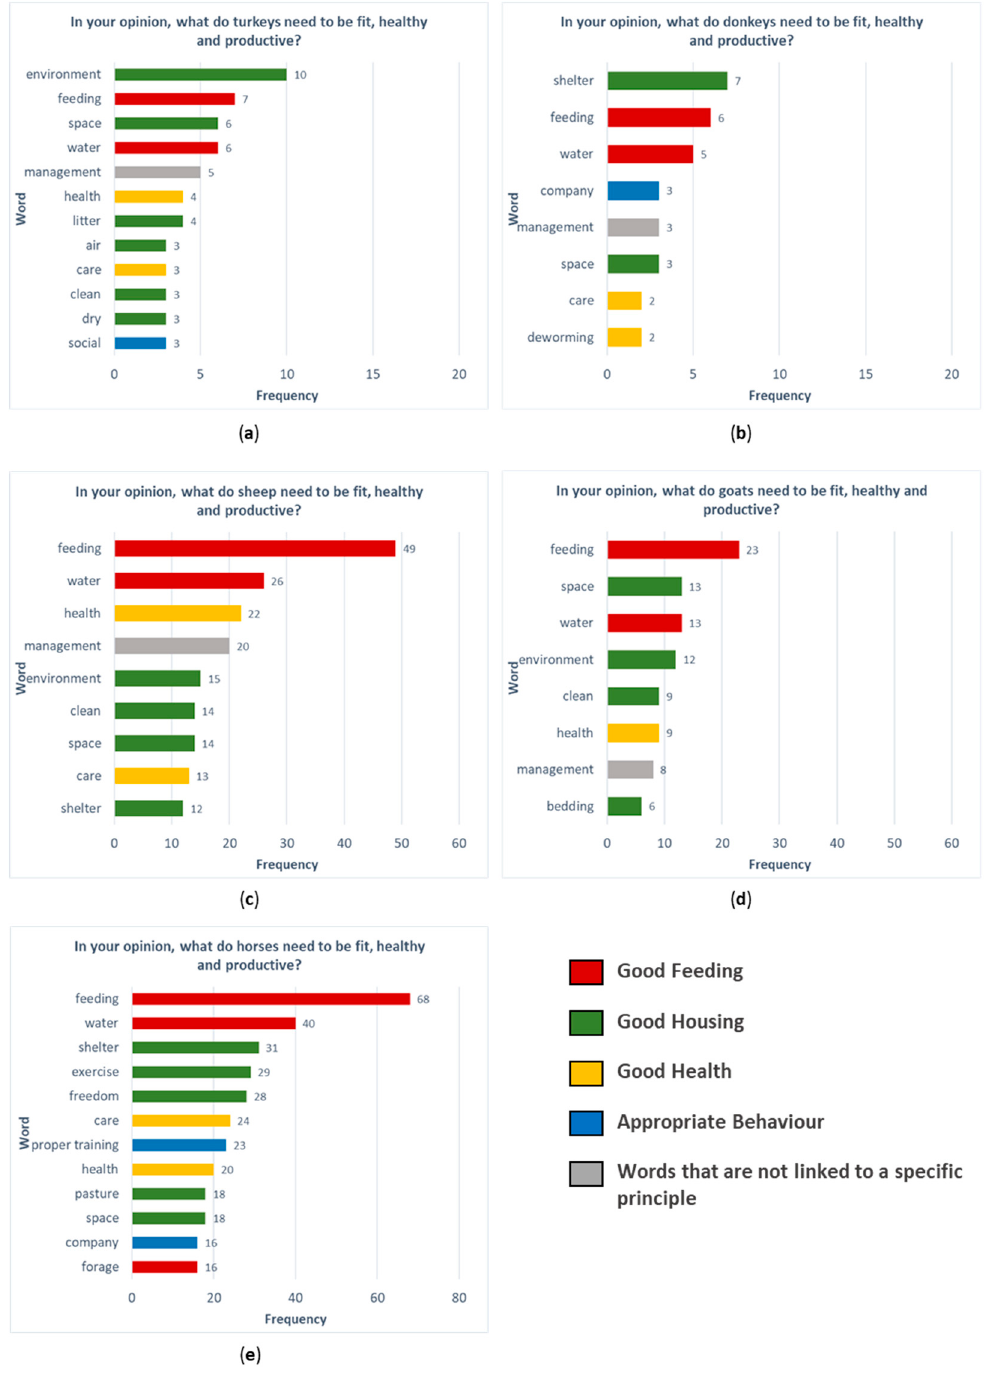
Figure 1. The graphs report the frequency of words used to answer the question “In your opinion, what do turkeys ( a ), donkeys ( b ), sheep ( c ), goats ( d ), and horses ( e ) need to be fit, healthy, and productive?” To highlight the association between each word and welfare principles [34], different colors are used: Red for “good feeding”, green for “good housing”, yellow for “good health”, blue for “appropriate behaviour”; grey is used for the words that are not linked to a specific principle.